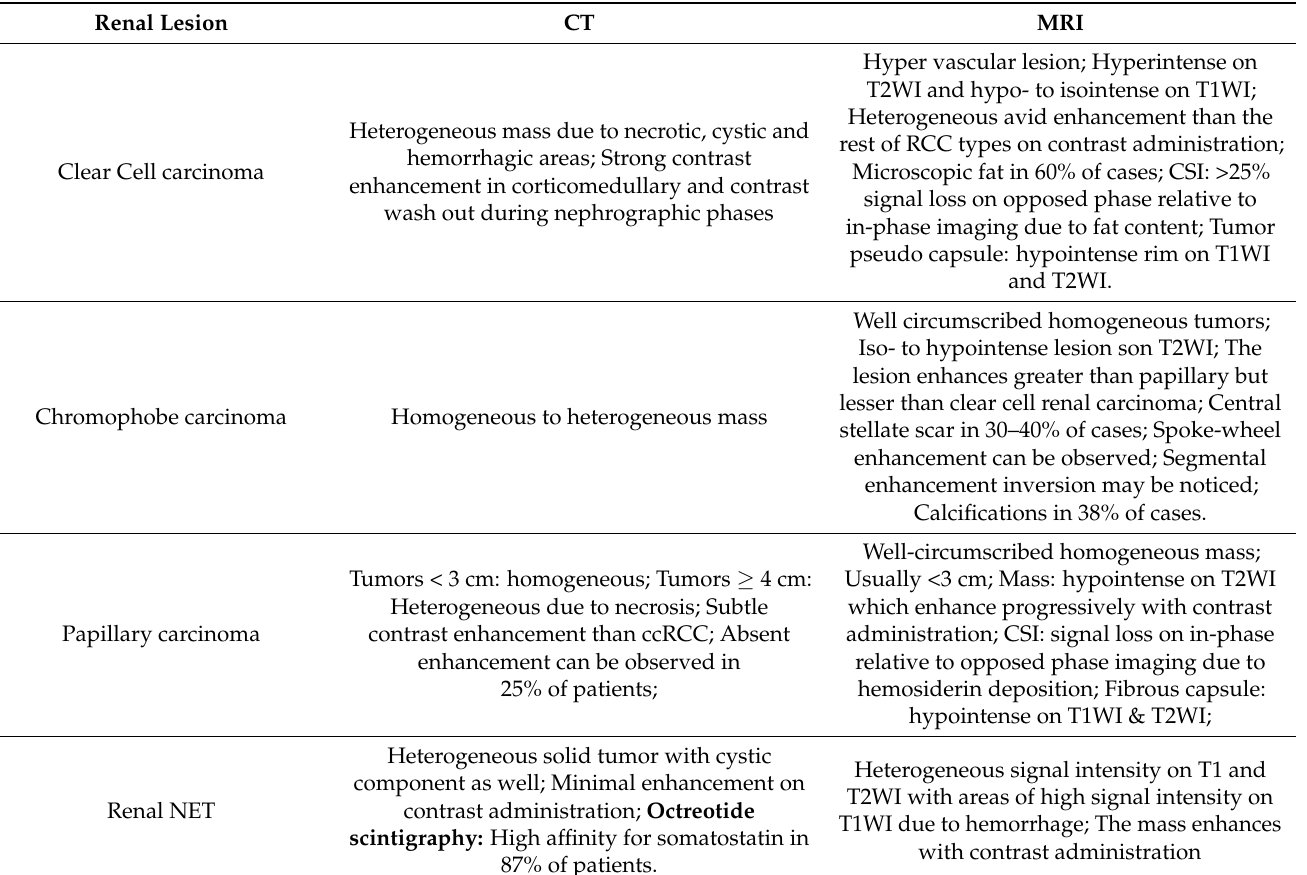
Table 2. Imaging features of solid renal masses